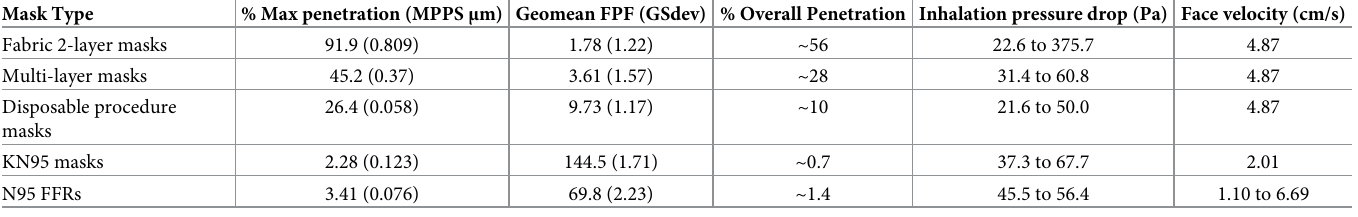
Table 1. Maximum penetration, geometric mean FPF, percent overall penetration, inhalation pressure drop and face velocity for the five mask groups: Fabric 2-layer, multi-layer, disposable procedure, KN95 and N95 FFRs. Mask Type